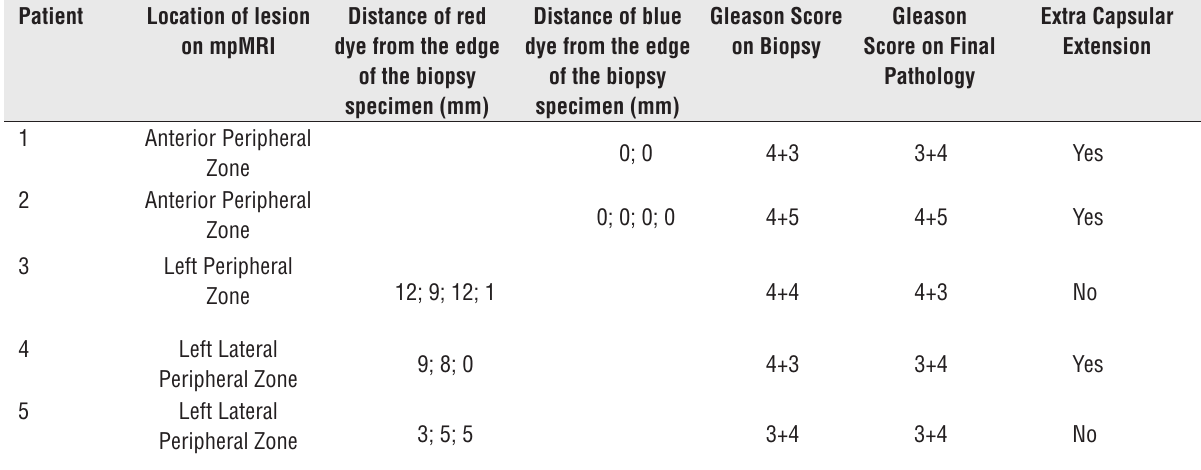
Table 2 - Pathological features of patients who underwent a radical prostatectomy. Patient